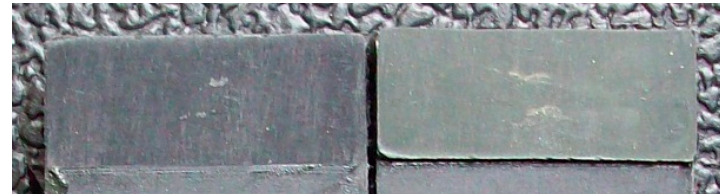
Figure 20. Fracture surface of the abraded specimen subjected to fatigue test.